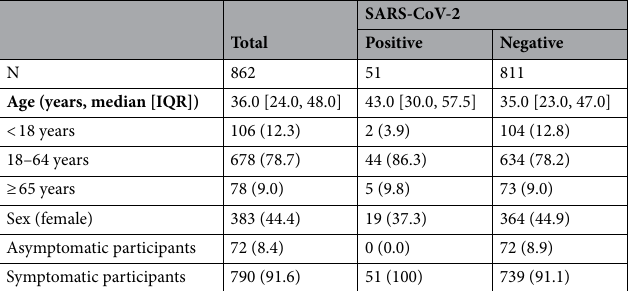
Table 1. Demographic data of the whole study population and cases infected with SARS-CoV-2. IQR interquartile range.